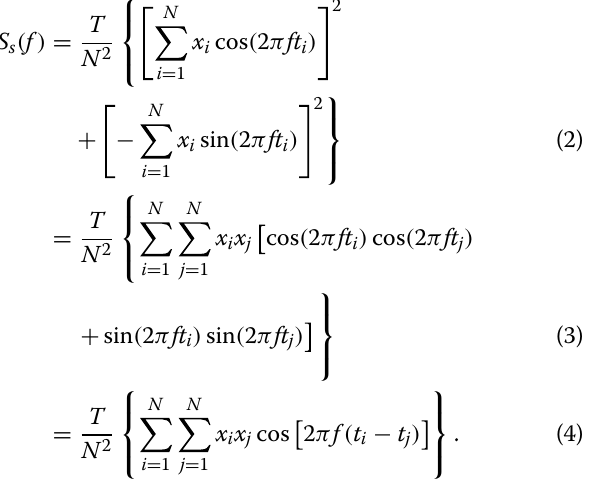
is applied, bias-free estimates are essential to obtain a consistent mean spectrum with vanishing systematic and random errors for an increasing sample